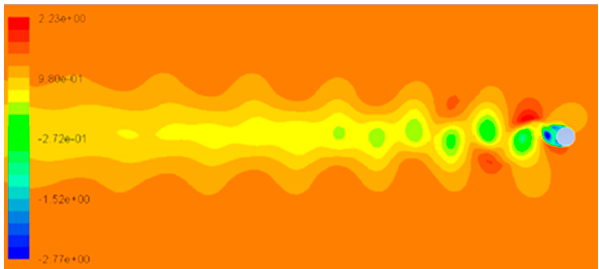
Figure 1. Shedding of alternate vortices behind a cylinder represented as pressure (N/m 2 ) contours. (Von Kármán Vortex Street).